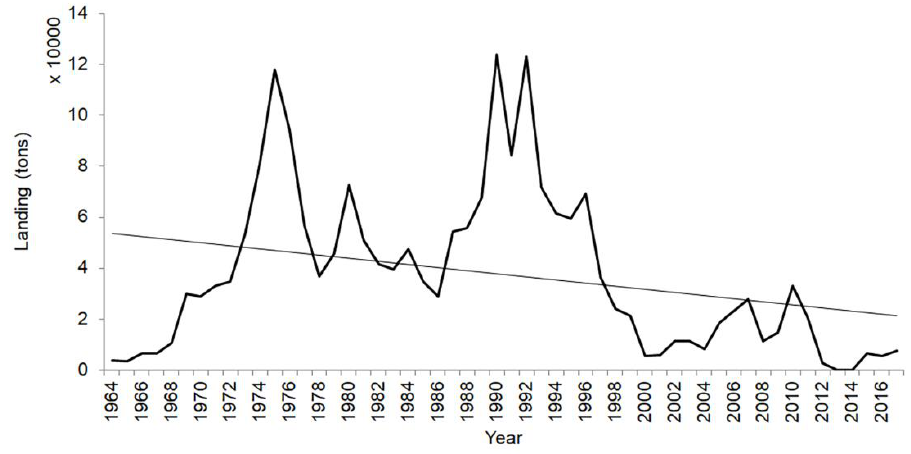
Figure 6. Landing of Sardina pilchardus of the artisanal fishery of Senegal (1964 to 2017). Data source: Centre de Recherches Océanographiques de Dakar-Thiaroye (ISRA/CRODT, Dakar, Senegal).